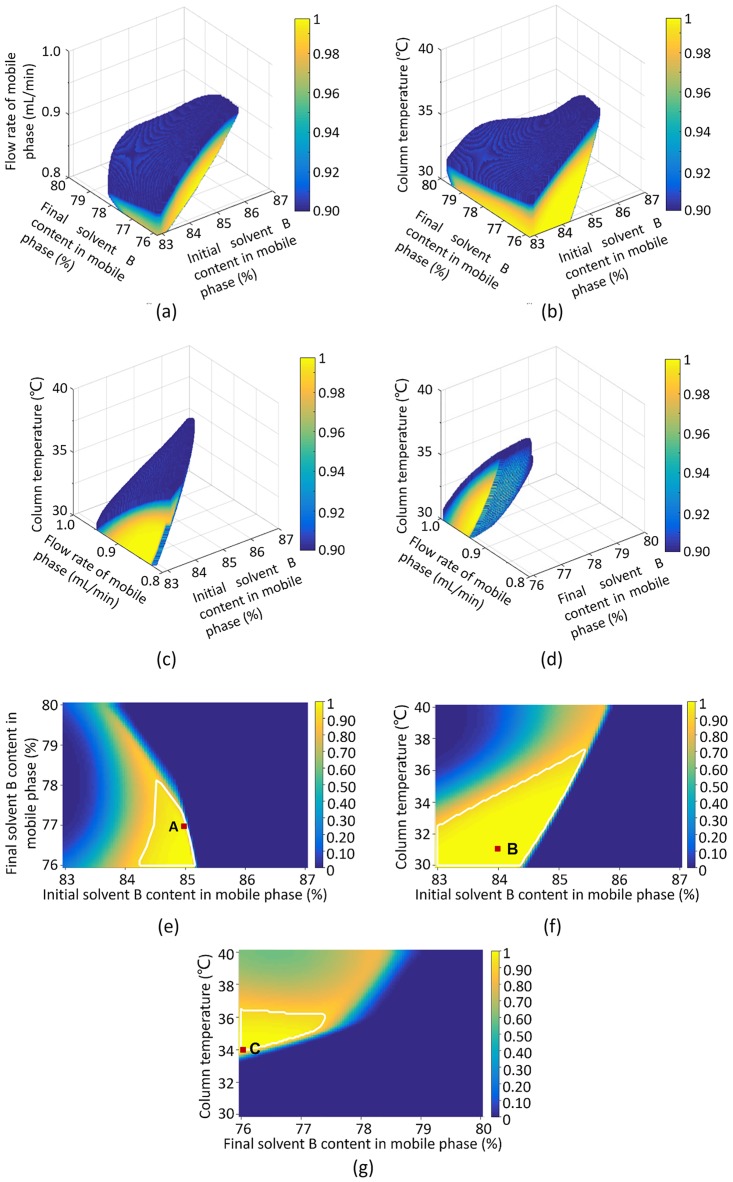
Analytical design space and verification points.(a) Column temperature = 35 °C; (b) Flow rate of mobile phase = 0.9 mL/min; (c) Final solvent B content in the mobile phase = 76%; (d) Initial solvent B content in the mobile phase = 85%; (e) Flow rate of mobile phase = 0.9 mL/min; column temperature = 35 °C; (f) Final solvent B content in the mobile phase = 76%; flow rate of mobile phase = 0.9 mL/min; (g) Initial solvent B content in the mobile phase = 85%; flow rate of mobile phase = 0.9 mL/min. Color bar refers to the probability to attain CMA goals; and the probability of areas surrounded by white borders to attain CMA goals was higher than 0.90.